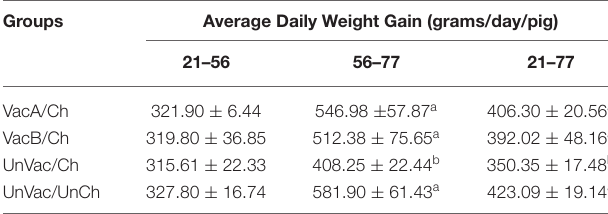
TABLE 2 | Average daily weight gain (ADWG) in pigs from different group. Groups